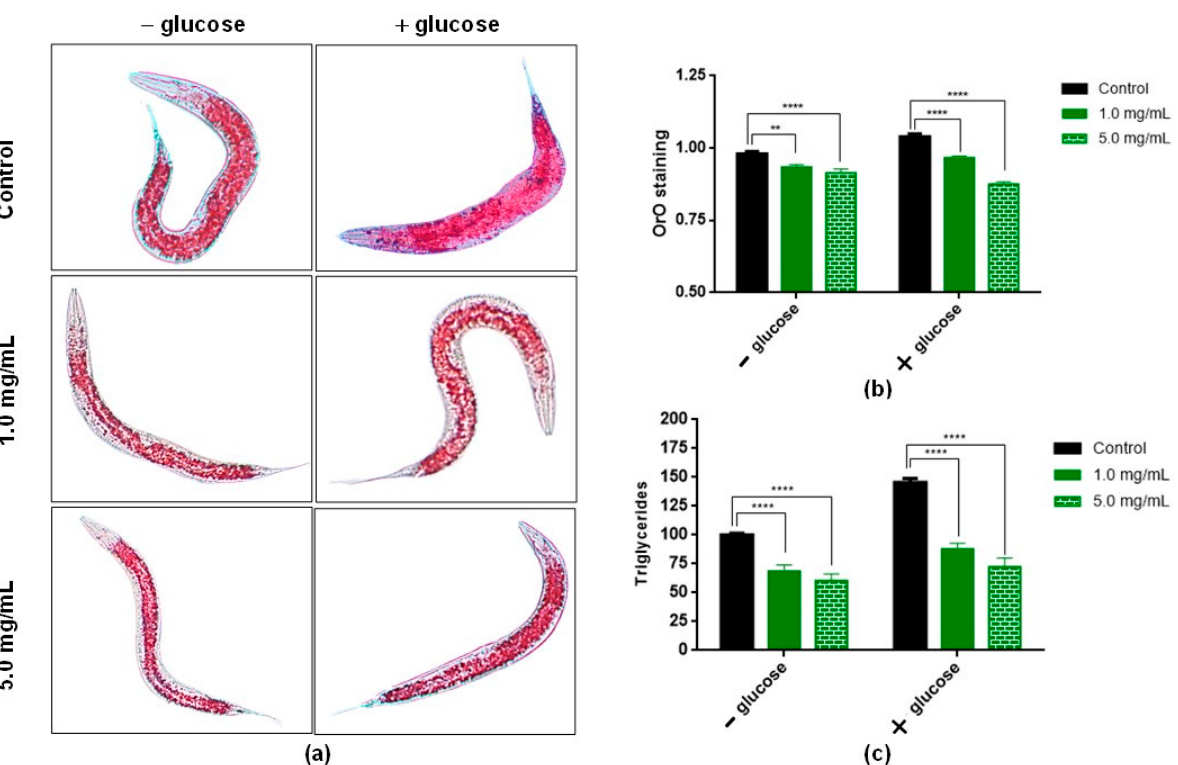
Figure 6. Effect of Baccharis trimera leaf extract (BT) on fat accumulation in wild-type C. elegans (N2) by Oil Red O staining and triglyceride quantification. L1 stage worms were treated with BT (1.0 or 5.0 mg/mL) for 48 h in absence or with glucose co-treatment. ( a ) Images were obtained from worms stained with Oil Red O. ( b ) Fat accumulation measured in red pixels normalized by body size. At least 20 animals per group were analyzed in each experiment in triplicate (total n = 60 animals). ( c ) Quantification of triglycerides. Data represent the mean ± standard deviation of three independent experiments. ** p < 0.01 and **** p < 0.0001, being statistically significant in relation to the control, according to ANOVA followed by a Tukey test. BT: Baccharis trimera aerial part extract; ANOVA: analysis of